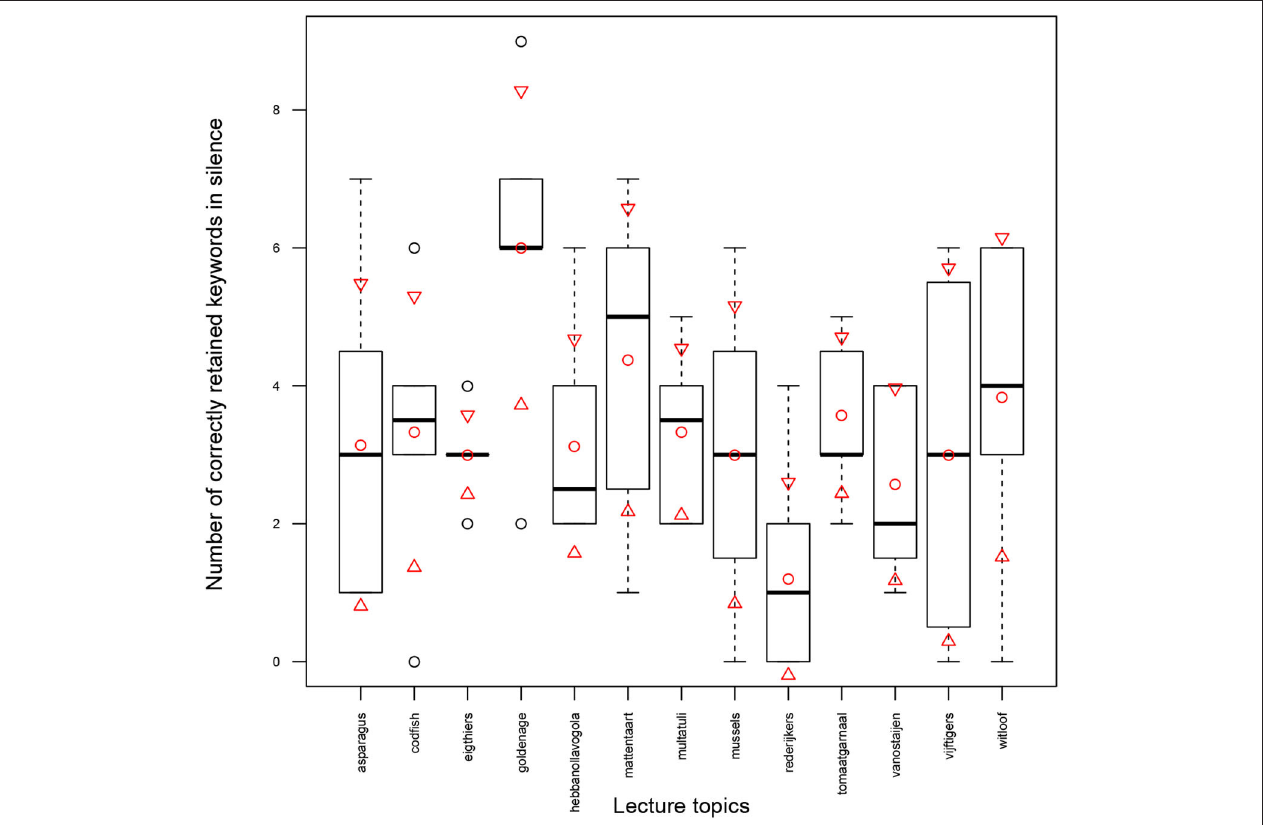
FIGURE 5 | Number of correctly retained keywords in silence (LA-PK) across 13 topics; mean and standard deviation values are shown by circles and triangles, respectively. The box-plots display the median marked as a bold line. The lower and upper whiskers represent another 50 % data distributed outside the interquartile box.